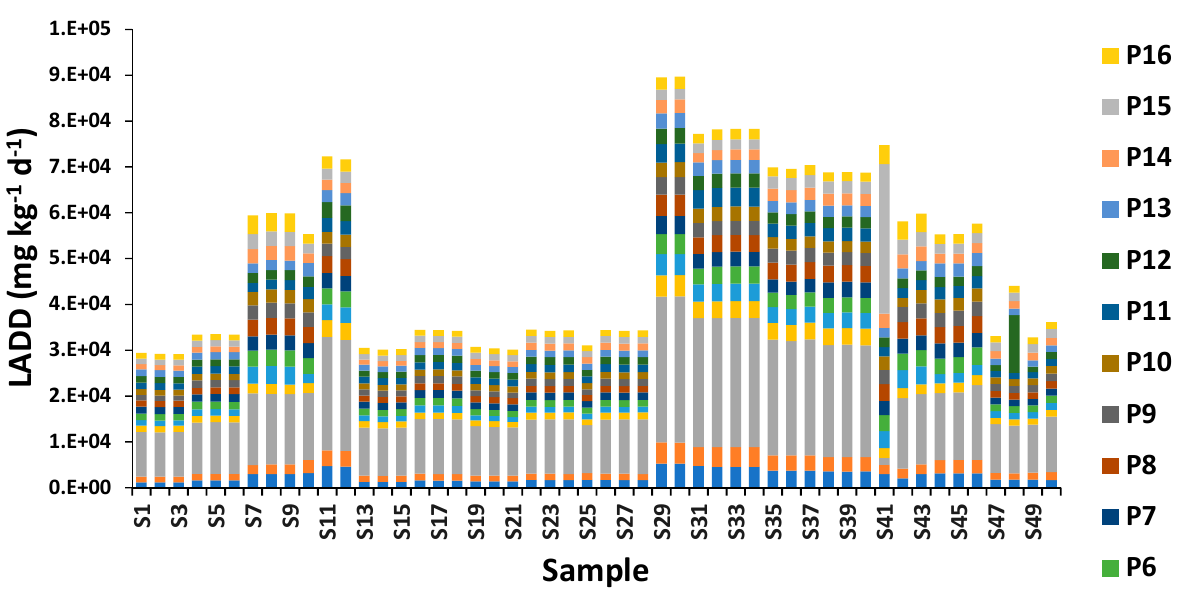
Figure 4. The lifetime average daily dose (LADD) of sixteen PAH against sampling locations. P1: